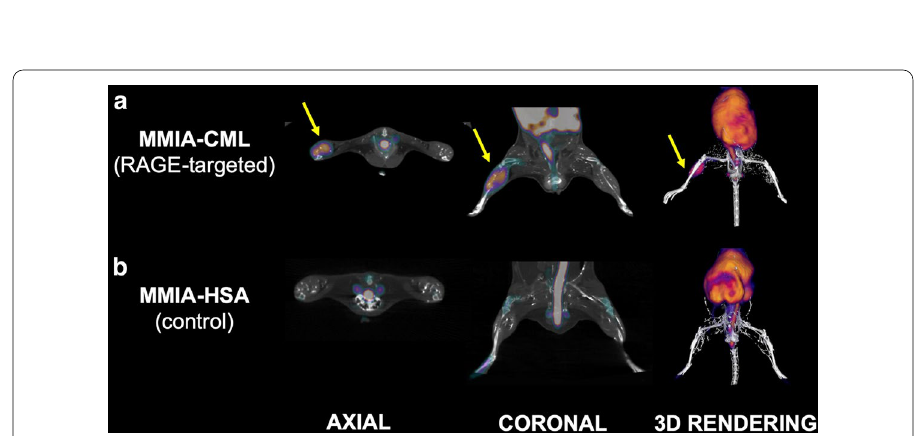
Fig. 2 Exemplary PET images of MMIA-CML ( a ) and MMIA-HSA ( b ) nanoparticles radiolabeled with 64 Cu acquired in a murine model at one week after surgical ligation of the right femoral artery. One hour after radiolabeled probe injection, animals were subjected to the imaging session. Nanoparticle targeted at RAGE notably bonded to the muscle tissue’s ischemic area (yellow arrows) versus the opposite non-ischemic hindlimb; neither ischemic nor non-ischemic hindlimbs exhibited recognizable accumulation of untargeted, control